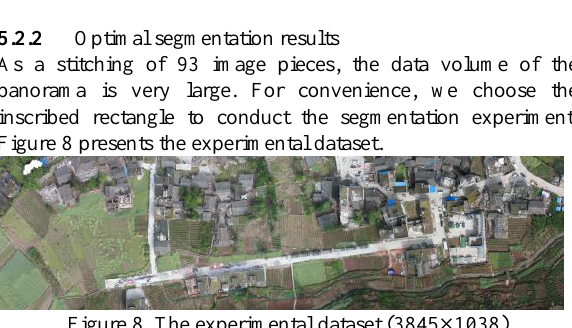
Figure 7. The stitching panorama of the post-seismic UAV